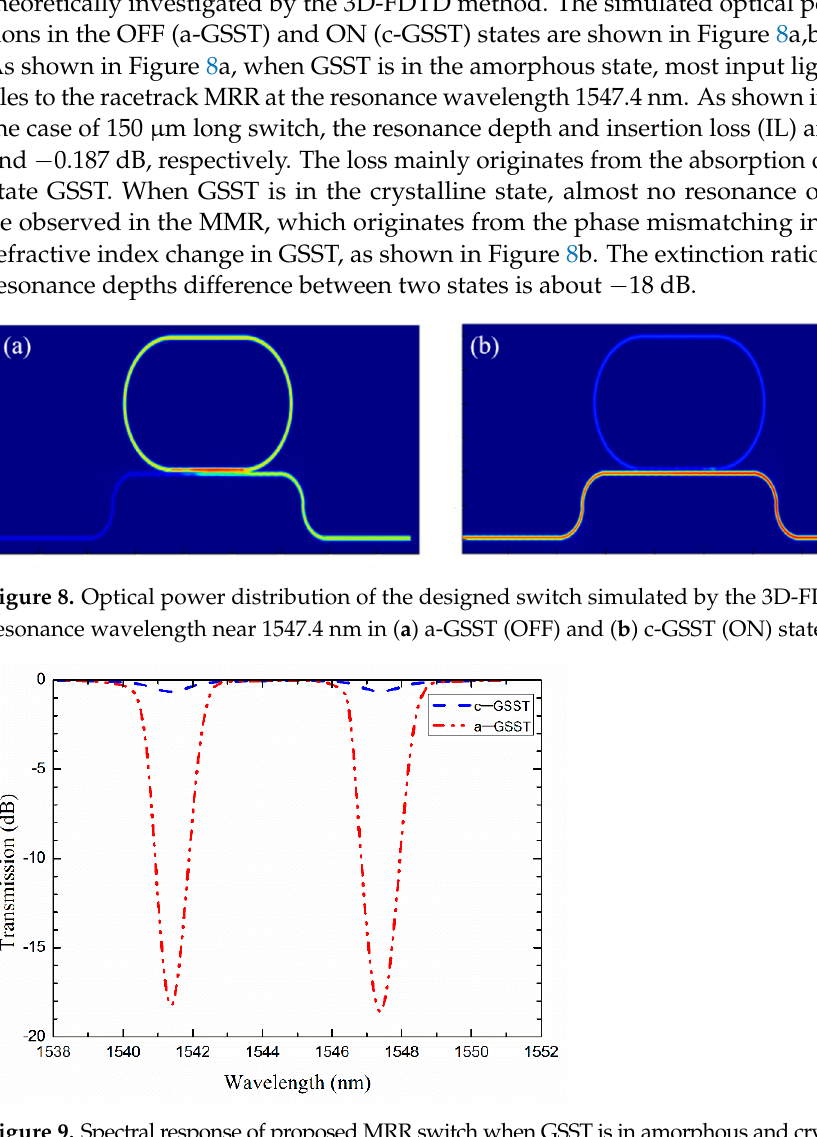
Table 1. Switching performance comparison with reported works.